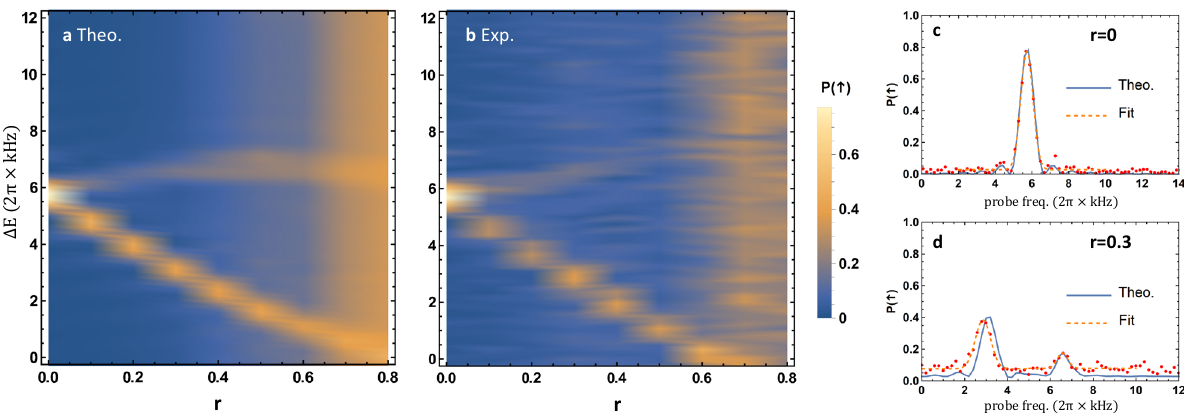
Fig. 2 QRM energy spectrum and SUSY. a Theoretical energy gaps between the ground state and the fi rst two excited states as a function of r in Eq. (2). b Experimentally measured energy gaps. At r = 0, the system is supersymmetric with a unique bosonic ground state and degenerate fi rst and second excited states for the bosonic and the fermionic modes. As r → 1, the Hamiltonian approaches the other supersymmetric point, but the unique ground state disappears and the lowest bosonic and fermionic states become degenerate, which indicates a spontaneous SUSY breaking. c , d The resonant signals probed by a weak pulse for energy gaps at r = 0 and r = 0.3, respectively. The solid blue curves are the theoretical results and the red dots are the measured data, which are fi tted by multiple Gaussian functions as the dashed orange curves to extract the peak locations. a b